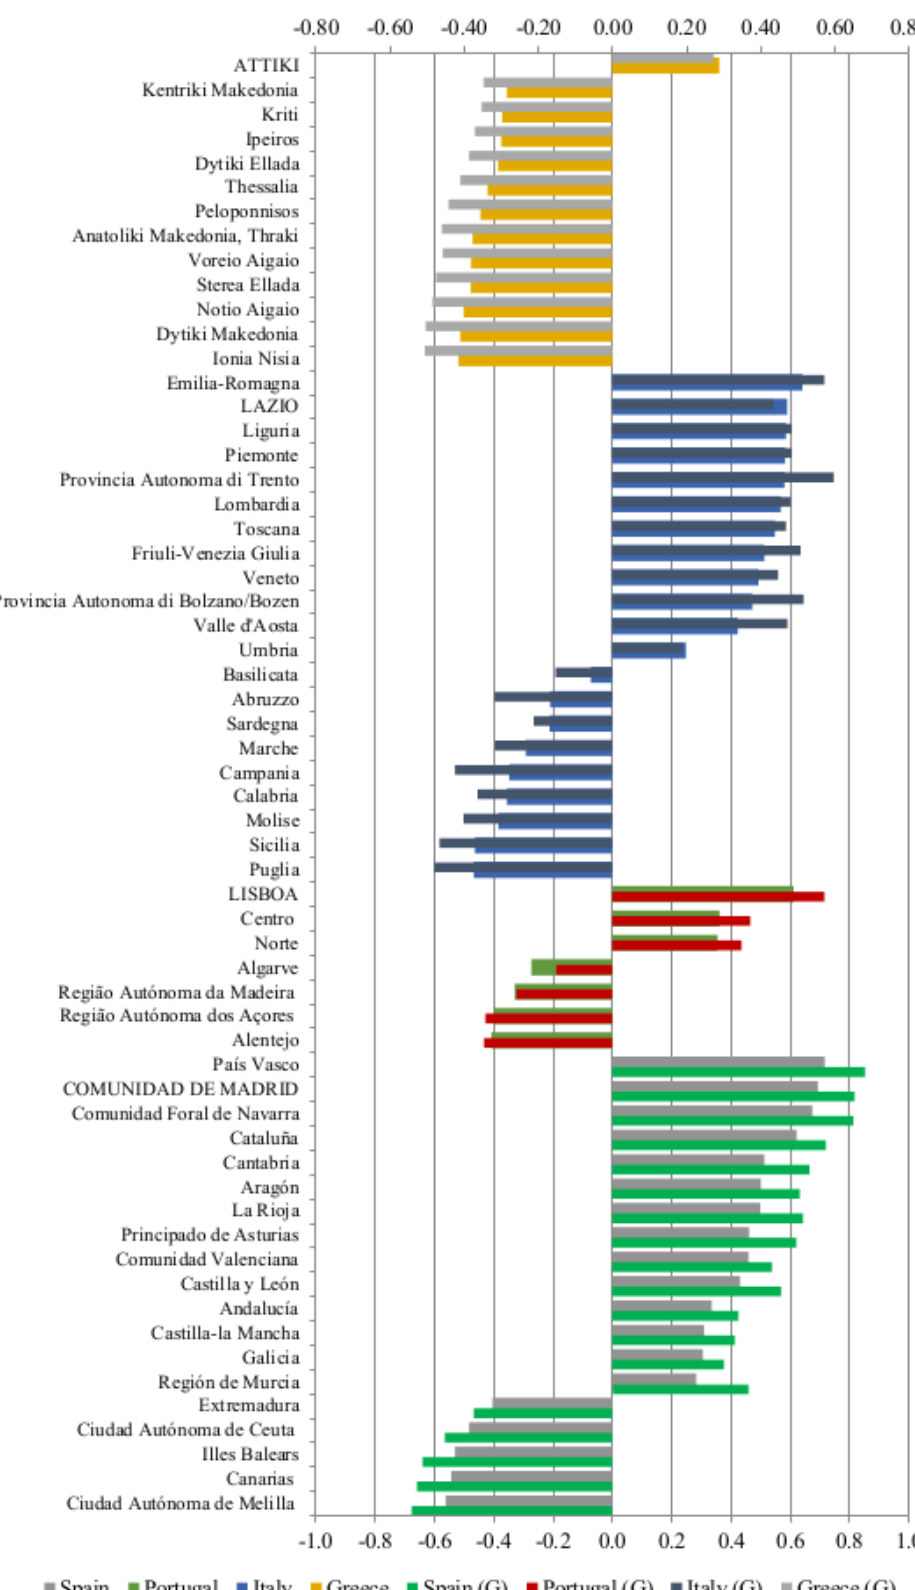
Figure 4: Basic Image values given by the model when using a three and a four-factor Economic Indicator respectively. The latter values are denoted by (G)